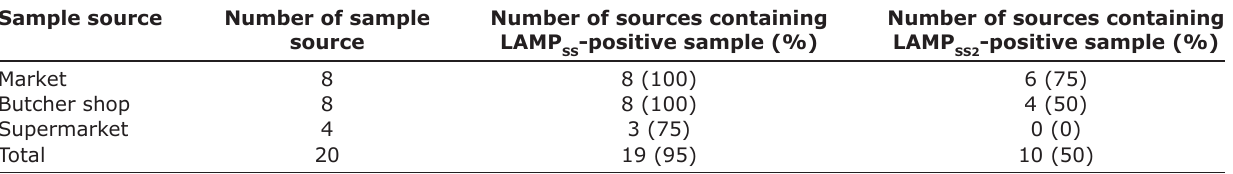
Table-3: Sources of samples used in this study and LAMP